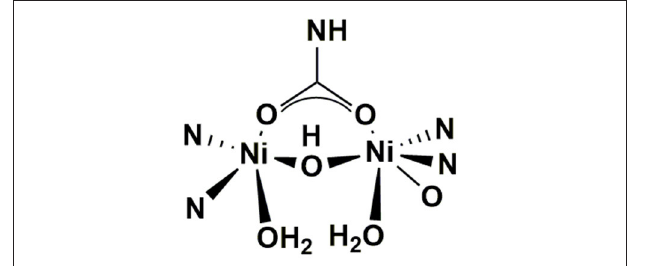
FIGURE 3 | Structure of Urease (Mazzei et al., 2019).